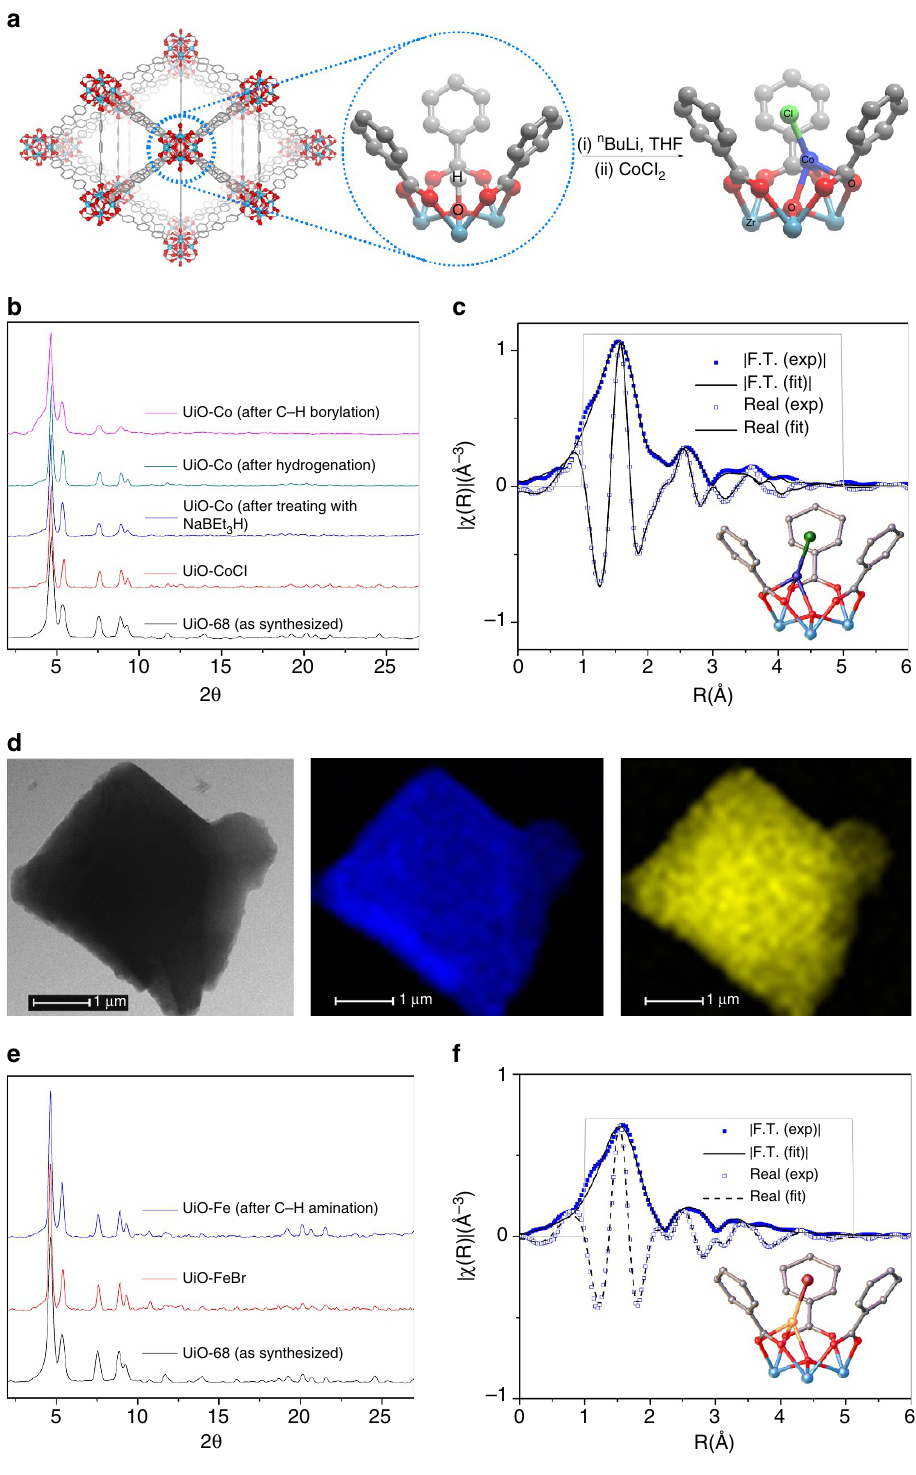
Figure 1 | Characterization of Co- and Fe-functionalized UiO-68. ( a ) Scheme showing the postsynthetic metalation of the SBUs of UiO-68 with CoCl 2 . ( b ) The similarities between the powder X-ray diffraction patterns of UiO-68 (black), UiO-CoCl (red), UiO-Co (blue) and UiO-Co recovered from hydrogenation of 1-octene (green) and recovered from C–H borylation of m- xylene (pink) indicate the retention of UiO-68 crystallinity after postsynthetic metalation and catalysis. ( c ) EXAFS spectra and the fits in R-space at the Co K-edge of UiO-CoCl showing the magnitude (solid squares, solid line) and real component (hollow squares, dashed line) of the Fourier transform. The fitting range is 1–5.0Å in R space (within the grey solid lines). ( d ) TEM-EDX mapping of UiO-Co: TEM image (left), Co distribution is shown in blue (middle), and Zr distribution is shown in yellow (right). TEM-EDX mapping of UiO-Co indicates that Co and Zr are evenly distributed throughout the MOF-particle. ( e ) The similarity of the powder X-ray diffraction patterns of UiO-68 (black), UiO-FeBr (red), and UiO-Fe recovered from C–H amination of tetralin (blue) indicates the retention of UiO-68 crystallinity after postsynthetic metalation and catalysis. ( f ) EXAFS spectra and the fits in R-space at the Fe K-edge of UiO-FeBr showing the magnitude (solid squares, solid line) and real component (hollow squares, dashed line) of the Fourier transform. The fitting range is 1–5.1Å in R space (within the grey solid